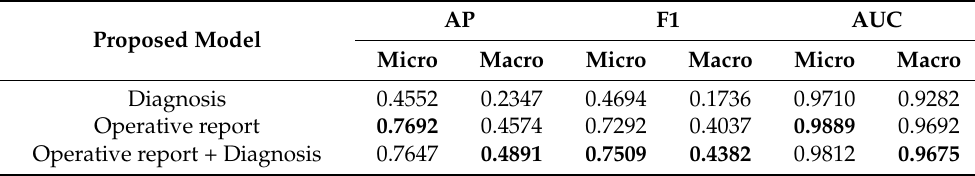
Table 3. Comparison of operative report and diagnosis data.